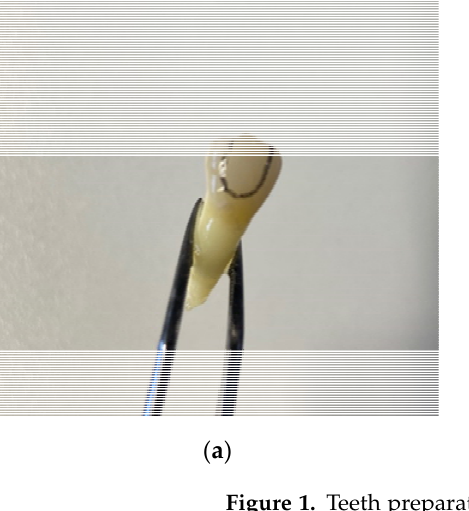
Figure 1. Teeth preparation steps: ( a ) preparation outline marked on the tooth surface; ( b ) tooth after preparation.